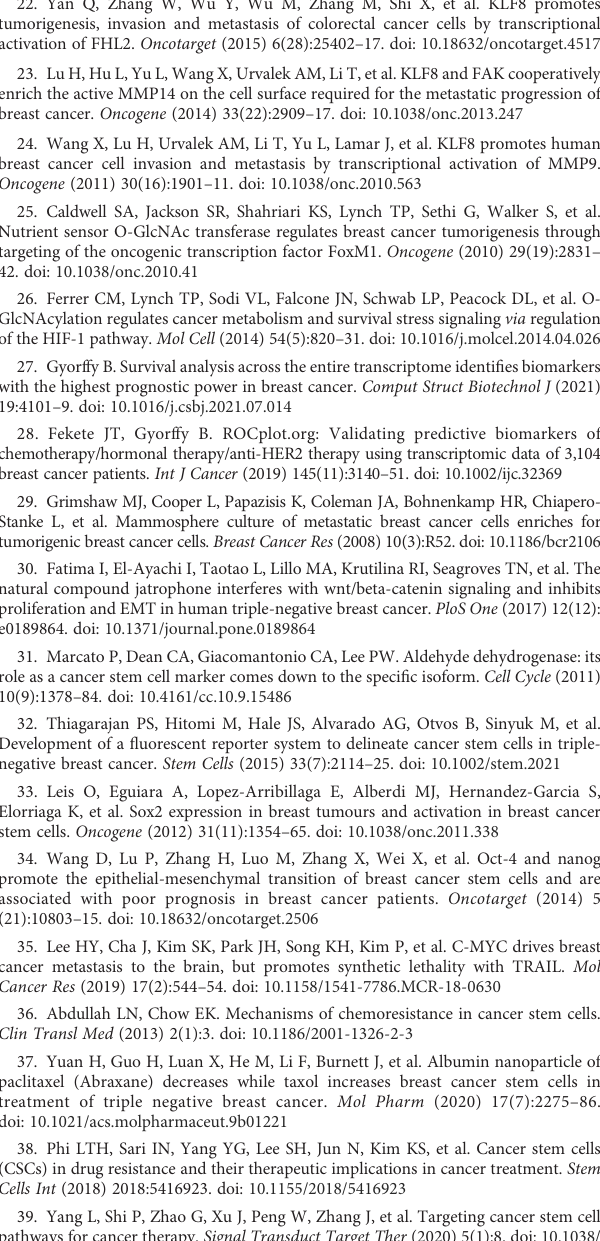
SUPPLEMENTARY FIGURE 4 (A) Quanti fi ed graph showing relative protein level of KLF8, OGT, and O- GlcNAc in MDA-MB-231 cells control or overexpressing KLF8 as detected by immunoblot using indicated antibodies (corresponding to ). Student t test reported as mean ± SEM, *p<0.05. (B) Quanti fi ed graph showing relative protein level of KLF8, OGT, and O-GlcNAc in MDA-MB-231 cells expressing